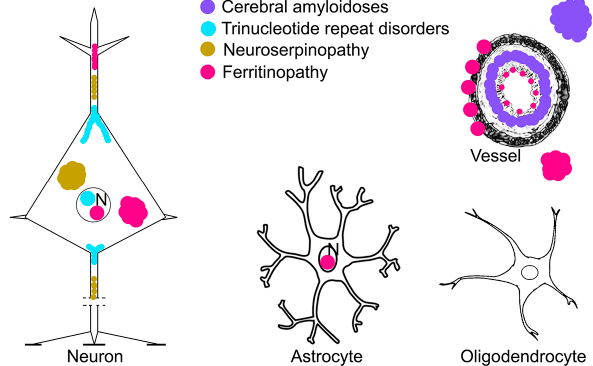
Figure 3. Cellular vulnerability patterns in rare hereditary forms of neurodegenerative diseases. N: nucleus. Since the drawing of the full extent of an axon would be out of the image the lines (---) in the axons indicate discontinuation (at the middle segment of the axon) of the drawing. Synapses are indicated by short black and bold lines (-).